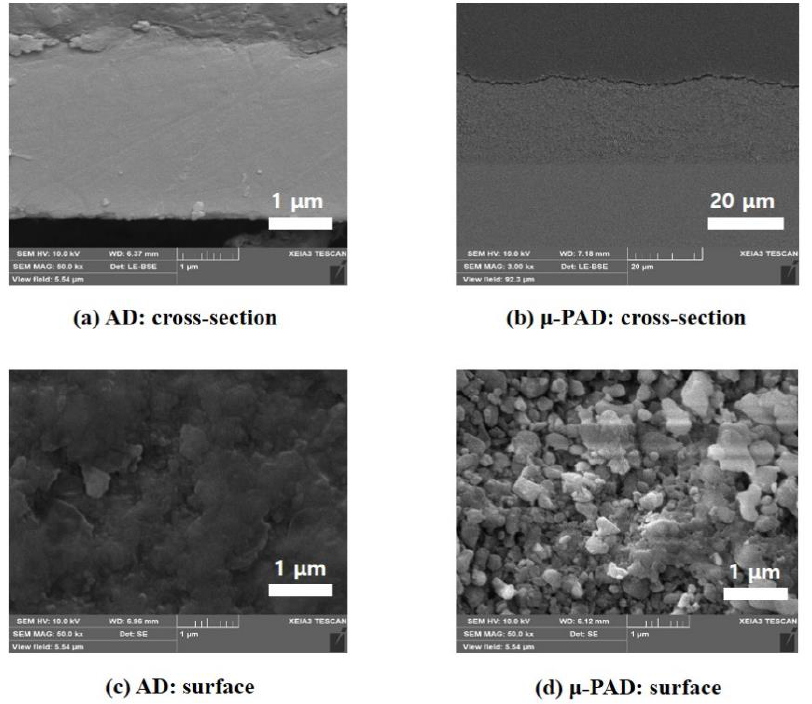
Figure 5. Scanning electron microscope images of AD and µ -PAD. Cross-sectional image of ( a ) AD and ( b ) µ -PAD. Surface image of ( c ) AD and ( d ) µ -PAD.